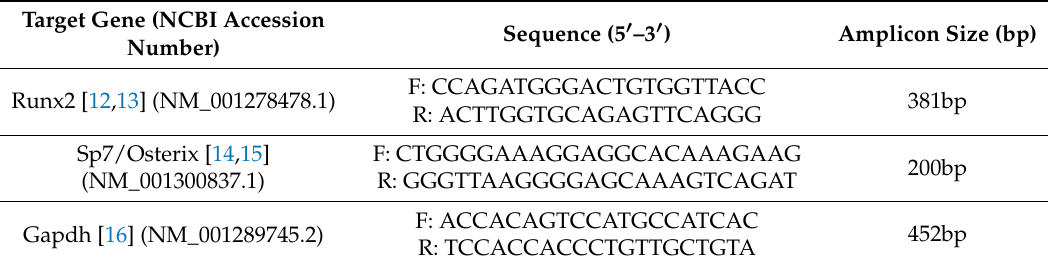
Table 1. Primers used in Reverse Transcription Quantitative Real-Time Polymerase Chain Reaction